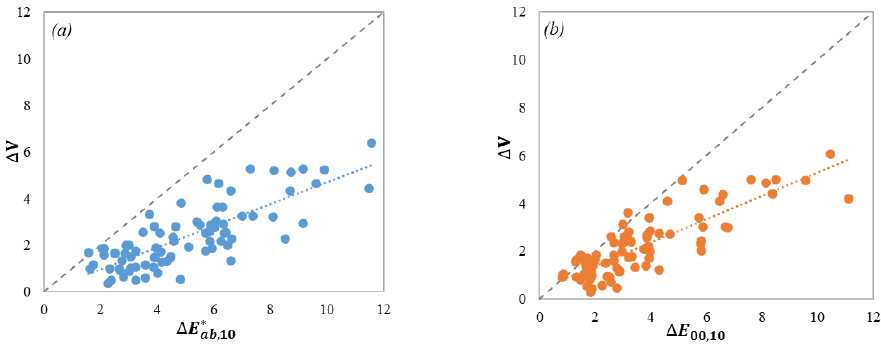
Figure 6. Plots of  V against ( a ) ∆𝐸 𝑎𝑏,10∗ and ( b ) ∆𝐸 00,10 for the 82 sample